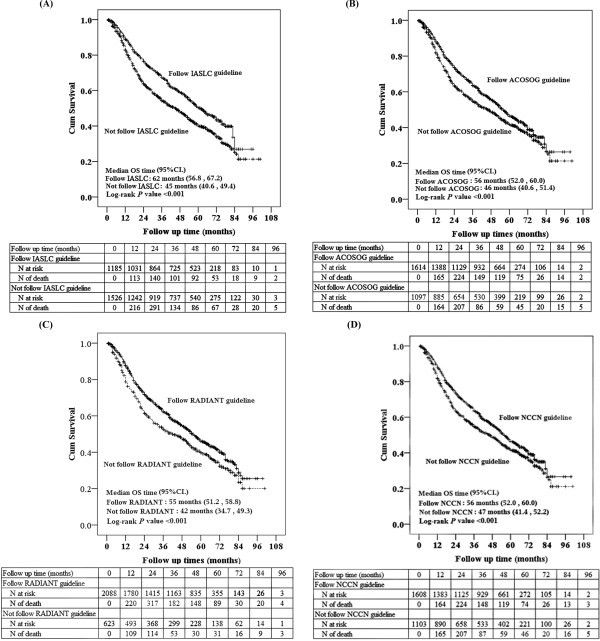
Kaplan-Meier curves of overall survival (OS) for patients in which the (A) IASLC, (B) ACOSOG, (C) RADIANT, and (D) NCCN GQR guidelines were or were not followed (+indicates censored cases). The log-rank test showed that OS was significantly different between patients in which the resection guidelines were followed compared with those in which the guidelines were not followed (all P < 0.001).